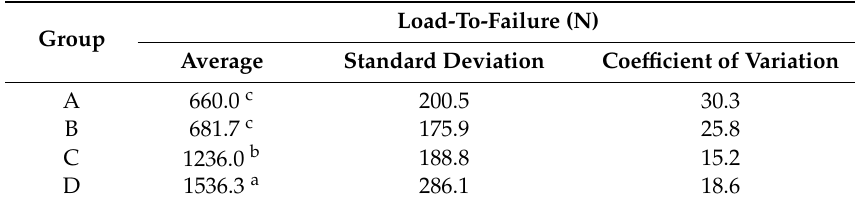
Table 4. Means and S.D. (N) for load-to-failure of repaired veneered zirconia crowns. Same lower-case letters in each column indicate no significant di ff erences ( p > 0.05).